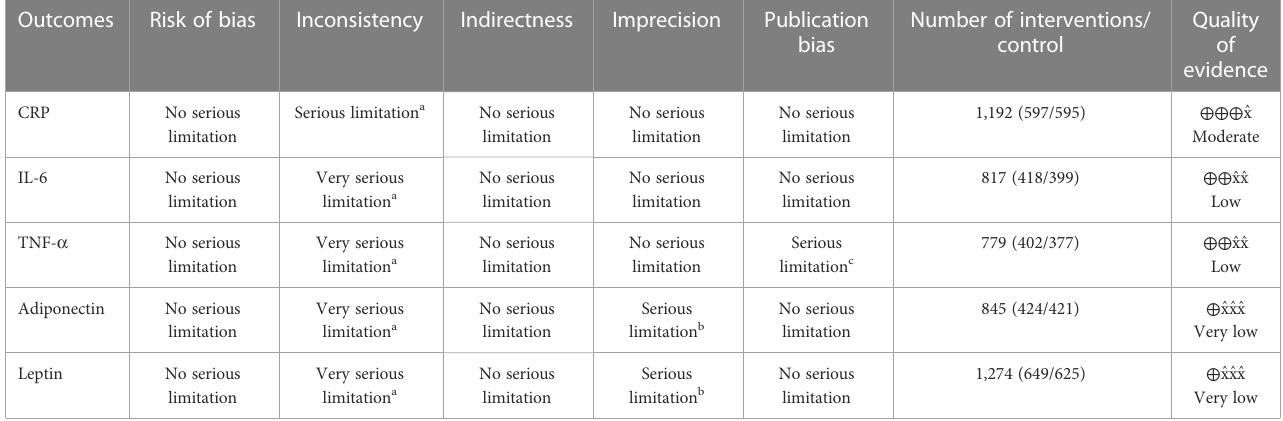
TABLE 4 GRADE pro fi le of CLA supplementation for in fl ammatory cytokines and adipokines. Outcomes Risk of bias Inconsistency Indirectness Imprecision Publication